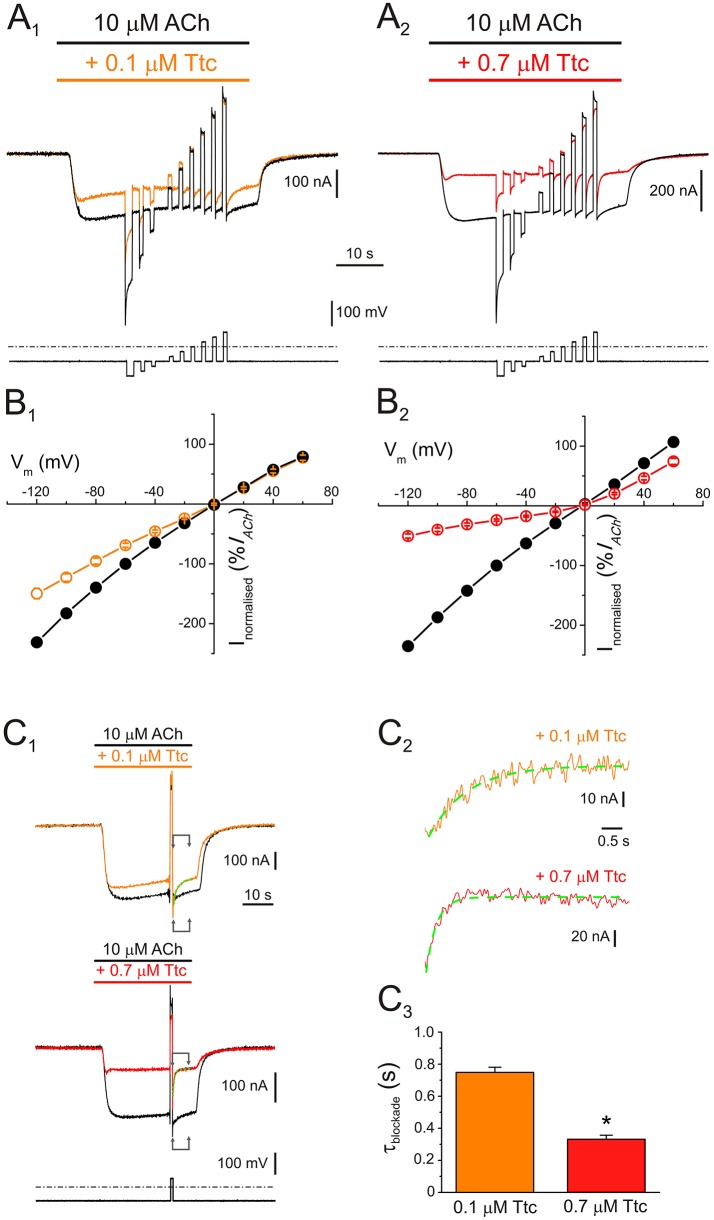
Voltage dependence of nicotinic acetylcholine receptor (nAChR) blockade by tetracaine (Ttc). (A)
IAChs (upper traces) elicited by 10 μM ACh either alone (A1,A2, black recordings), or in the presence of 0.1 μM (A1, orange), or 0.7 μM Ttc (A2, red) when the voltage protocol, indicated below the currents, was applied. (B) Plots of net i/v relationships for IAChs evoked, following the protocol shown in A. Control IAChs are represented by black symbols and lines (B1,B2), whereas those evoked in the presence of 0.1 μM (B1) and 0.7 μM Ttc (B2) are drawn in orange and red, respectively. Values were normalized as a percentage of current with reference to their control IACh at −60 mV. Each point is the average of 5 (N = 1) and 12 (N = 3) cells for 0.1 and 0.7 μM Ttc, respectively. (C) Kinetics of the voltage-dependent blockade of nAChRs at −60 mV. (C1)
IAChs were elicited by 10 μM ACh alone (control, black recordings), or together with either 0.1 μM (orange trace) or 0.7 μM Ttc (red recording) at −60 mV; during the IACh plateau, an 800 ms voltage jump to +40 mV was given (bottom trace shows the voltage protocol). Membrane leak currents (recorded in the absence of ACh) have been subtracted. (C2) Zoomed in view of the areas indicated by arrows in C1 (immediately after the voltage jump). Kinetics of the voltage-dependent blockade of nAChRs by 0.1 μM (orange trace) and 0.7 μM Ttc (red trace) were determined by fitting the net IACh decays to exponential functions (green curves over the recordings). The small, slow IACh changes evoked by the voltage pulse when the cell was bathed solely with ACh (black recordings in C1) have been subtracted. (C3) Time constant values of the voltage-dependent IACh blockade kinetics elicited by 0.1 and 0.7 μM Ttc. Asterisk indicates significant differences between both values (p < 0.05, t-test).